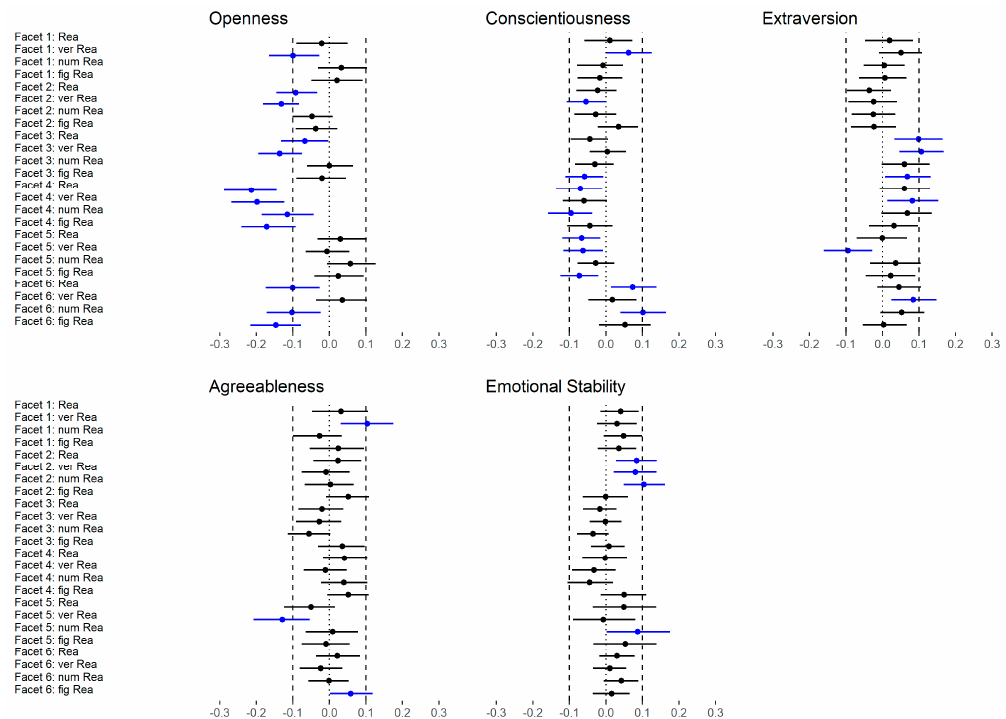
Figure 9. Study 1: Evaluation of the Brunswik Symmetry principle with regard to personality. Change of correlations when facets (low level) were considered instead of FFM dimensions (medium level). Rea = reasoning, ver = verbal, num = numerical, fig = figural. Blue lines indicate substantially different correlations based on an equivalence testing approach.